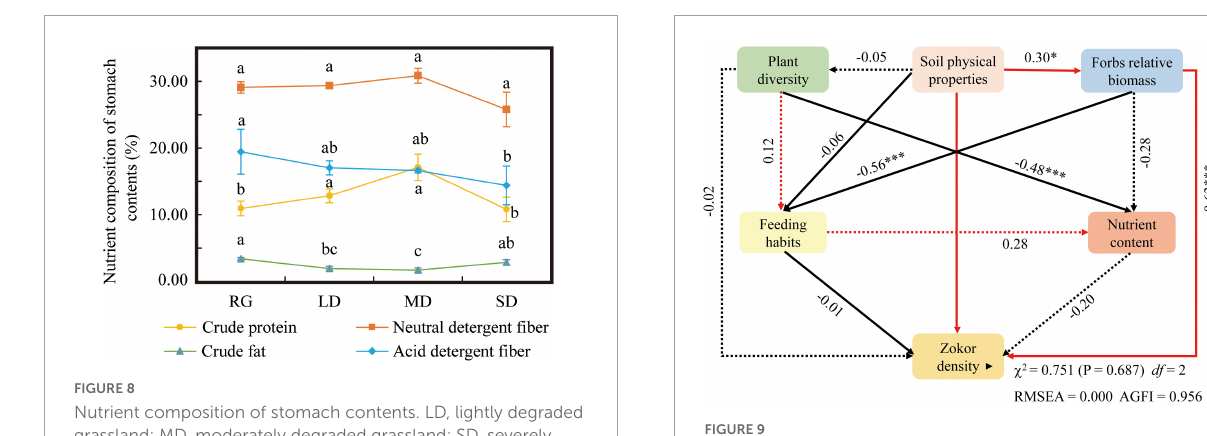
FIGURE8 Nutrient composition of stomach contents. LD, lightly degraded grassland; MD, moderately degraded grassland; SD, severely degraded grassland; RG, reseeded grassland. Different letters indicate significant differences between groups ( P < 0.05).